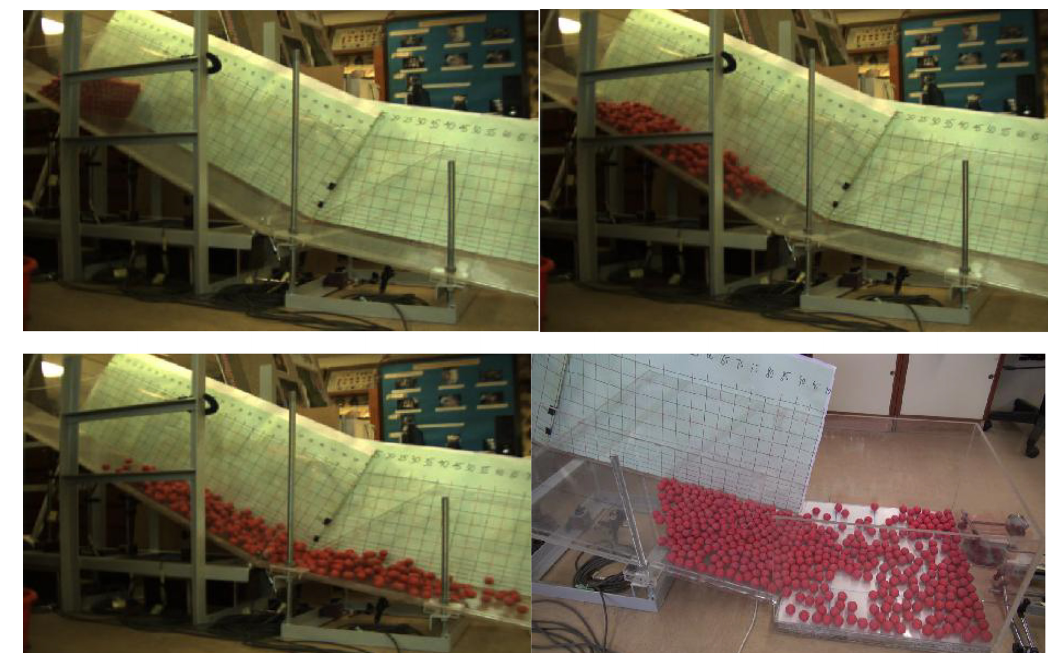
Figure 7. Flow pattern of mono-size particle flow in the physical